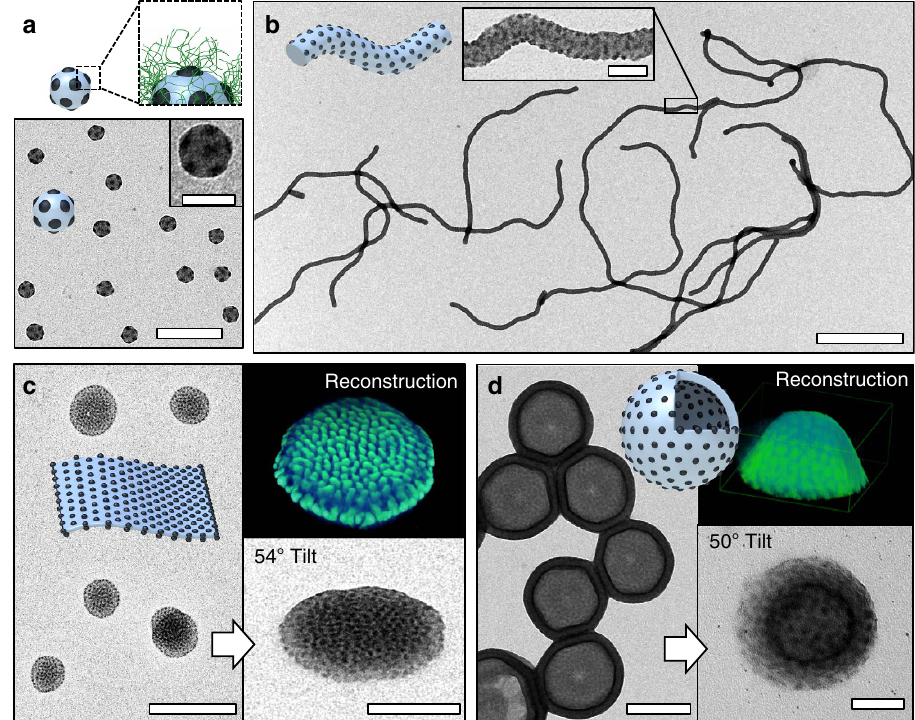
Figure 2 | Micelle polymorphs with spherical patches. Samples were prepared from acetone/isopropanol 60:40 (v/v) unless otherwise noted. ( a ) Spheres-on-spheres of S 1105 B 237 T 654 . Schematic of block arrangement shows PS core (grey), PB patches (black) and PT corona (green); this domain sequence applies to all nanostructures and the PT corona always emanates from the dark PB domains. Scale bars, 200 and 50nm in the inset. ( b ) Spheres-on-cylinders of S 540 B 173 T 137 ; close-up shows the small PB patches. Scale bars, 1 m m and 100nm in the inset. ( c ) Spheres-on-sheets of S 540 B 173 T 137 in acetone/isopropanol (85:15v/v), close-up recorded at 54 (cid:2) tilt angle and tomographic reconstruction showing PB patches in green. Scale bars, 500 and 200nm in the inset. ( d ) Spheres-on-vesicles of S 540 B 173 T 88 ; close-up recorded at 50 (cid:2) tilt angle and tomographic reconstruction showing PB patches in green. Scale bars, 200 and 50nm in the